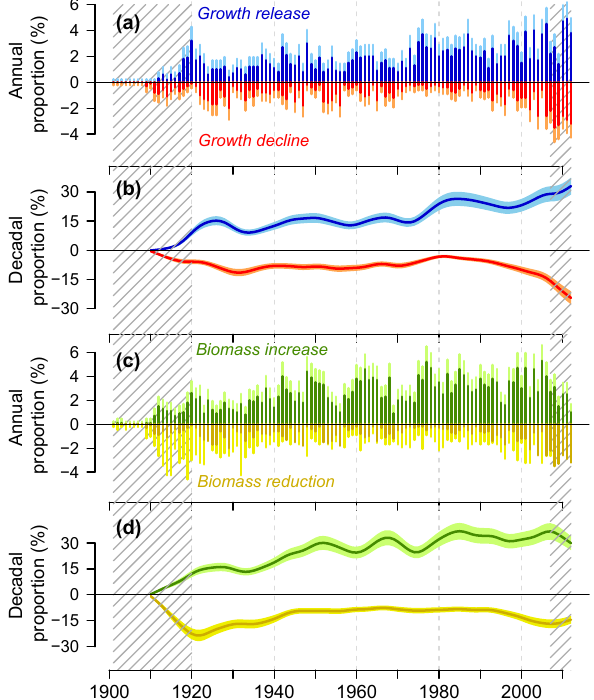
Figure 6. (a) Annual and (b) decadal (smoothed over 10-year sums) proportions of cells showing a significant decline or release in NPP with 90% confidence intervals (error bars) computed using Bayes’ method. (c) Annual and (d) decadal (smoothed over 10-year sums) proportions of cells showing a significant reduction or increase in biomass total aboveground with 90% confidence intervals (error bars) computed using the same